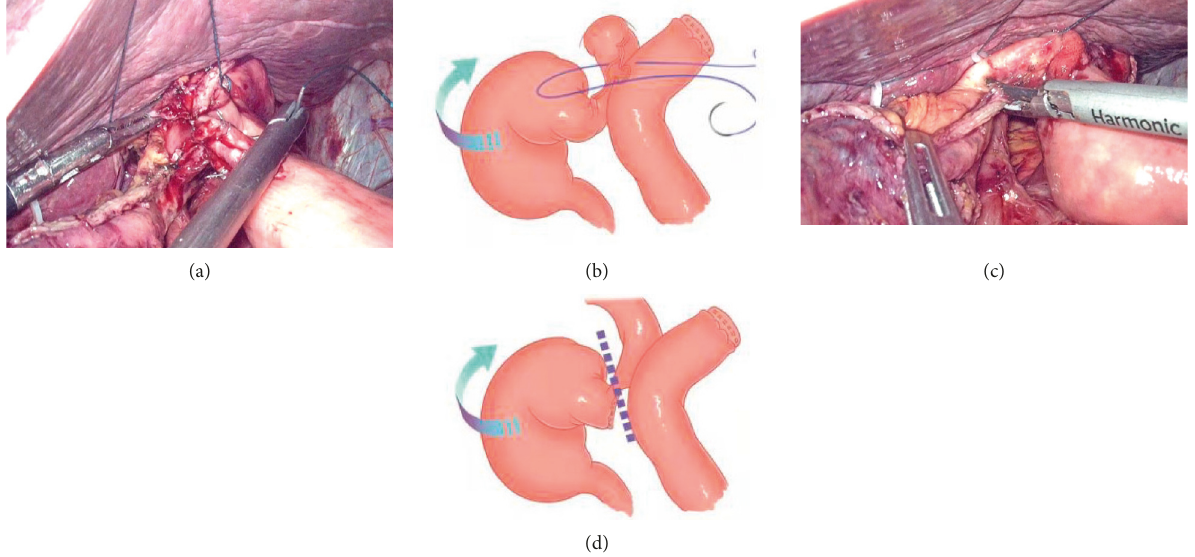
Figure 4: (a, b) A 3-0 barbed wire from left to right continuous sutured closure common opening. (c, d) Ultrasound knife transected the remaining part of the esophagus.